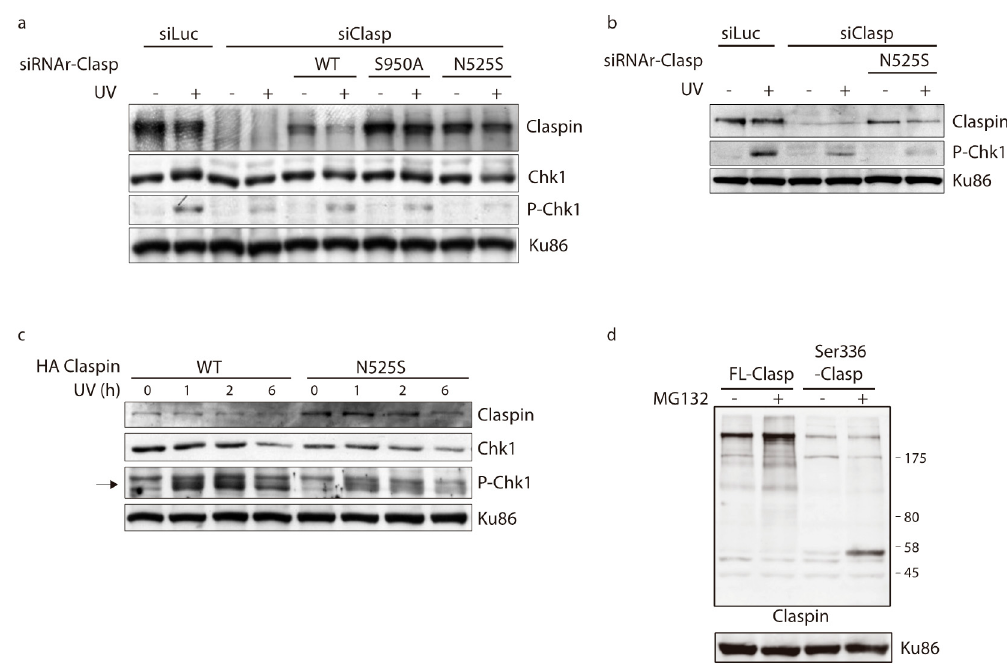
Figure 3. Claspin c.1574A > G mutants, p.N525S and p.Ser336Thrfs*13, impact Claspin expression and function. ( a ) and ( b ) U2 OS cell lines stably expressing HA tagged WT, S950A or N525S versions of Claspin, also containing silent mutations to the small interfering RNA, were transfected with siRNA against Claspin to deplete endogenous Claspin. The cells were then treated with UV (40 J / m 2 ) and collected at 1-h post irradiation to be analysed by Western blot against the indicated antibodies. ( c ) a similar experiment to ( a ) and ( b ) was performed with the stable cell lines expressing WT and N525S versions of Claspin and cells were collected at the indicated time points after UV treatment (40 J / m 2 ); the arrow indicates the phosphorylated form of Chk1 at Serine 317. ( d ) Full length or Ser336 Flag expressing plasmids were transfected in HEK293T cells and 24 h after transfection were incubated when indicated with the MG132 proteasome inhibitor. Protein Ku86 was included as loading control in all blots. Detailed information about western blot can be found at Figure S2.